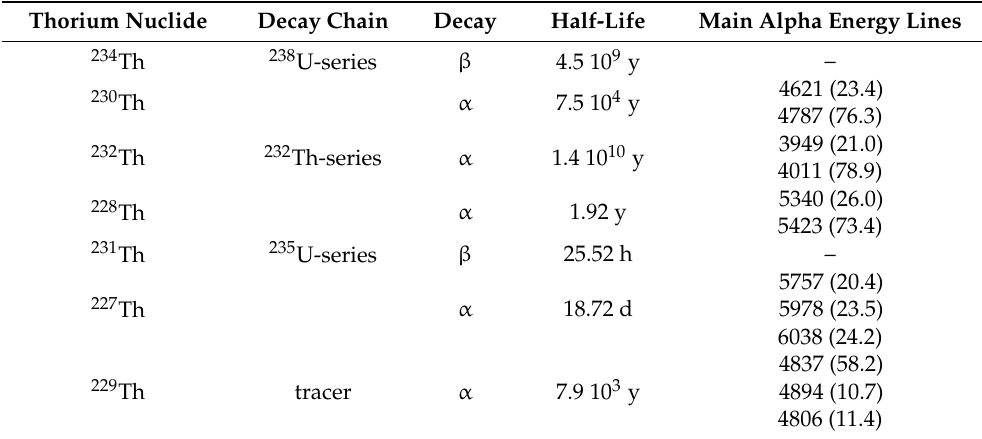
Table 7. Properties of thorium nuclides of the natural decay series and the tracer 229 Th. Alpha energy lines in keV with emission probability in %. All data from